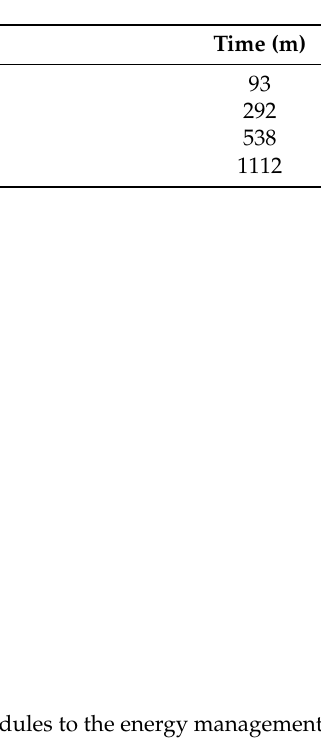
Table 2. 10 F Super capacitor charging time with a piezoelectric device.